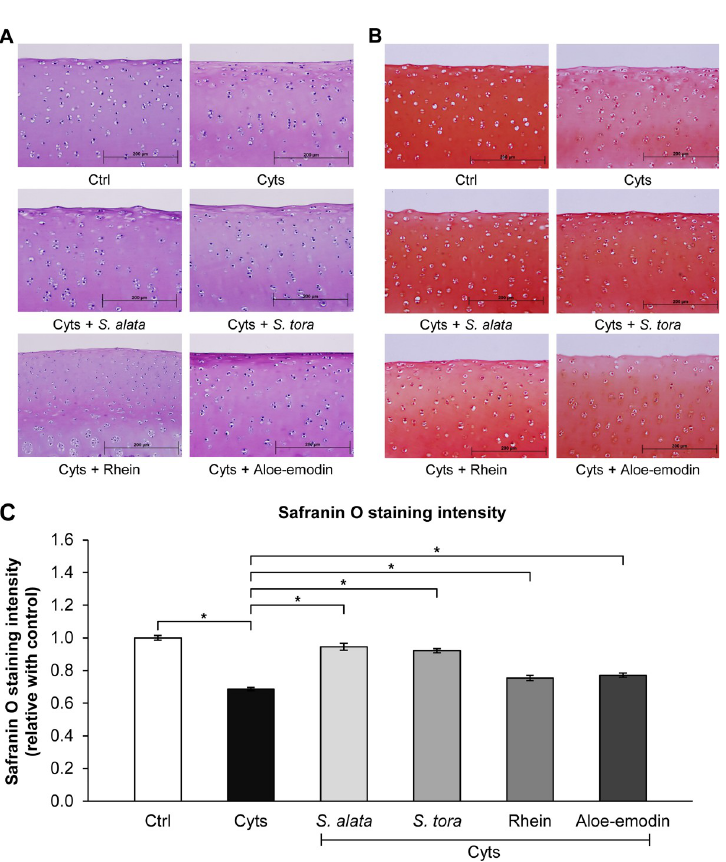
Fig 6. Histological examinations of the cartilage explants after 21 days of the long-term culture. Explants stained with H&E (A) or safranin O (B). Bar graphs (C) represent the color intensity of safranin O staining of cartilage explants. Results are expressed as mean ± SD from triplicate experiments. The asterisk ( � ) indicates a significant difference at p < 0.05. Cyts: the combined cytokines (2 ng/mL IL-1 β and 4 ng/mL IL-17A); Ctrl: control (untreated